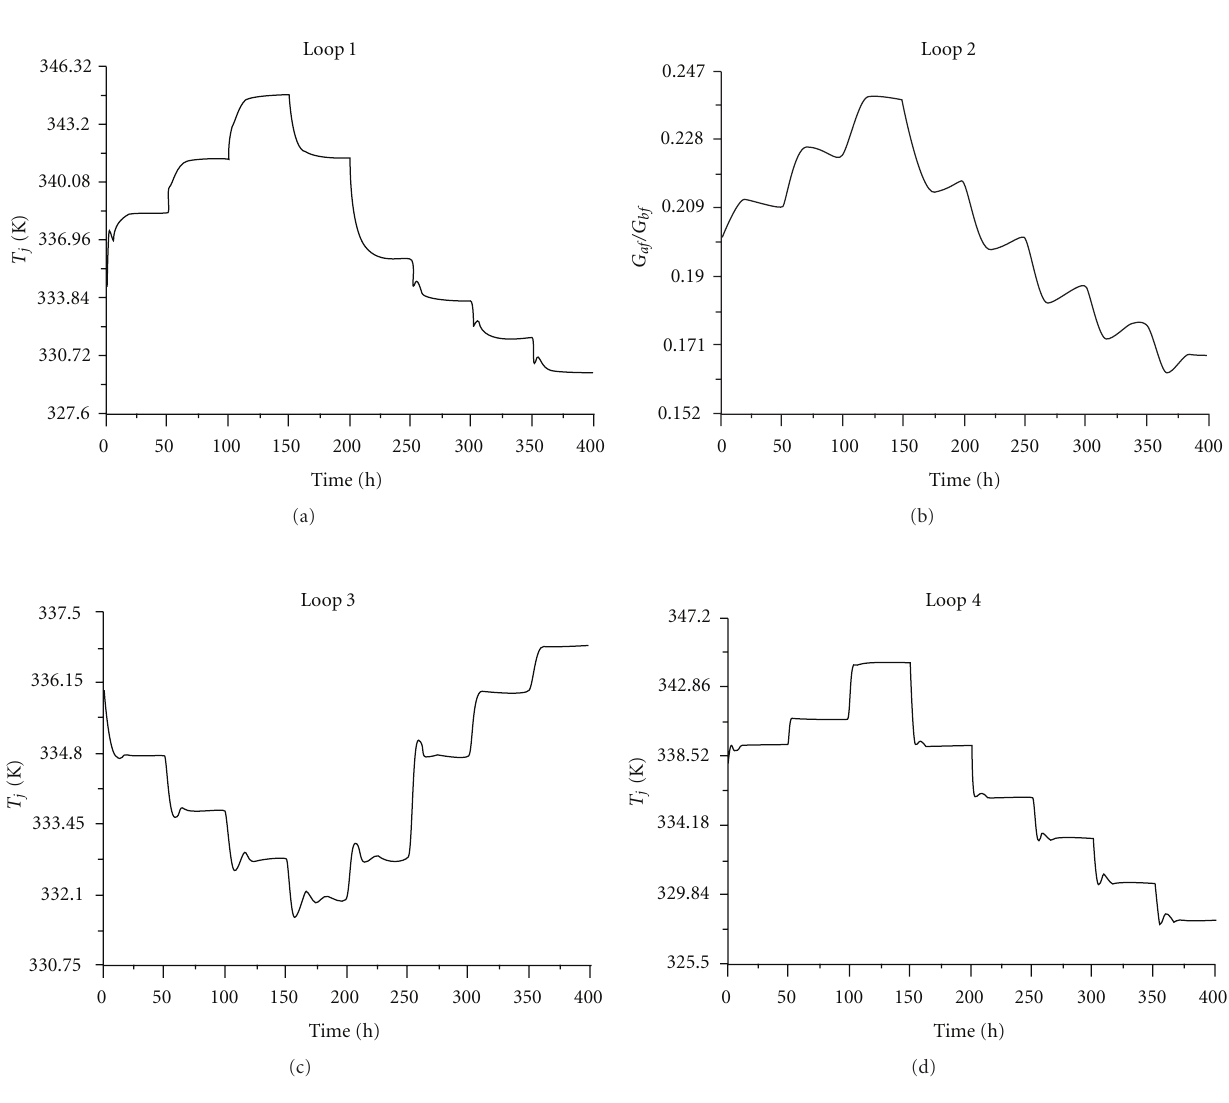
Figure 8: Manipulated variables profile for changes in set